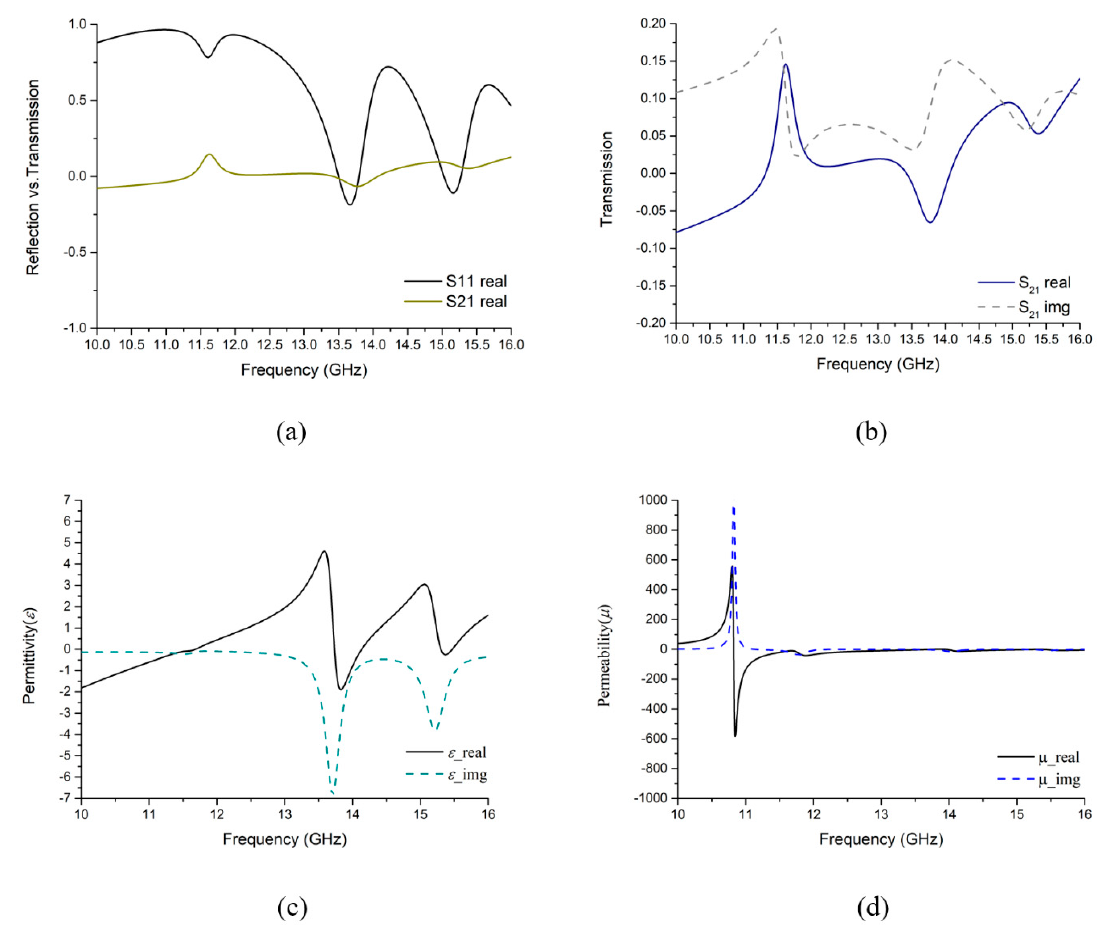
Figure 8. Reflection and Transmission properties in simulated design ( a ) Reflection vs. Transmission, ( b ) Transmission characteristics, ( c ) Permittivity ( ε ), ( d ) Permeability ( µ ) with Frequency spectrum.